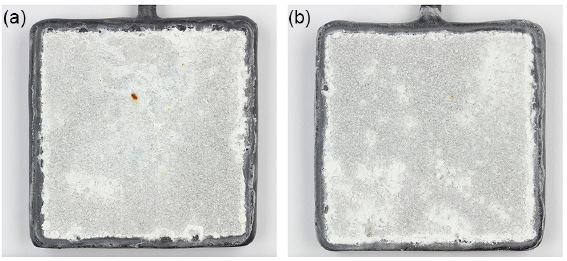
Figure 7. Photographs of ( a ) 0.15 mm and ( b ) 0.30 mm thick coating samples after the immersion